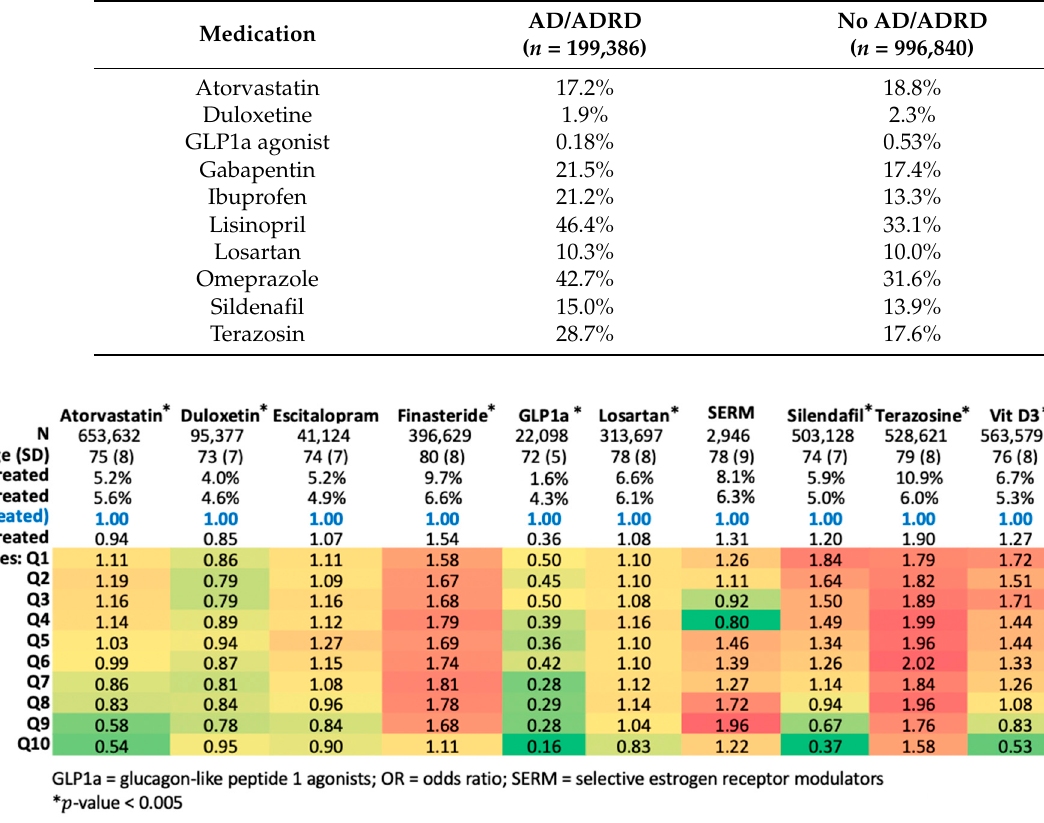
Figure 2. Heatmap of medication dose and ADRD risk. Of note, these data displayed are only to demonstrate the feasibility of MWAS and these are not adjusted